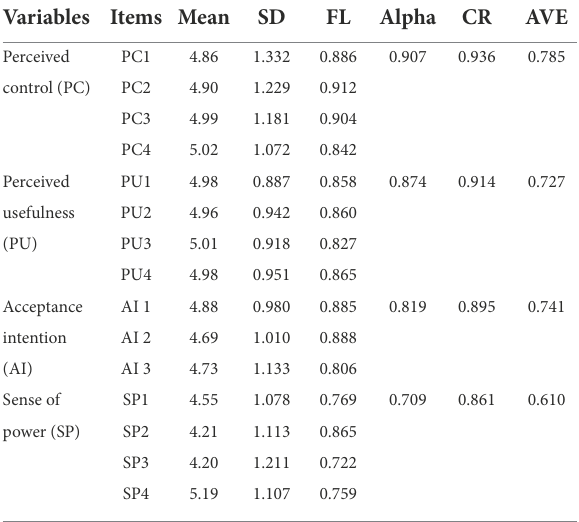
TABLE 1 Test for reliability and validity. TABLE 2 Correlation coefficient matrix.